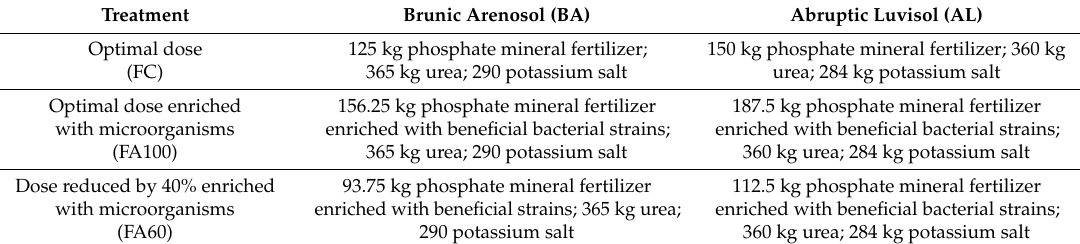
Table 3. The treatments arrangements within the field experiments. The doses of applied; fertilizers / biofertilizers were calculated per ha separate for each soil